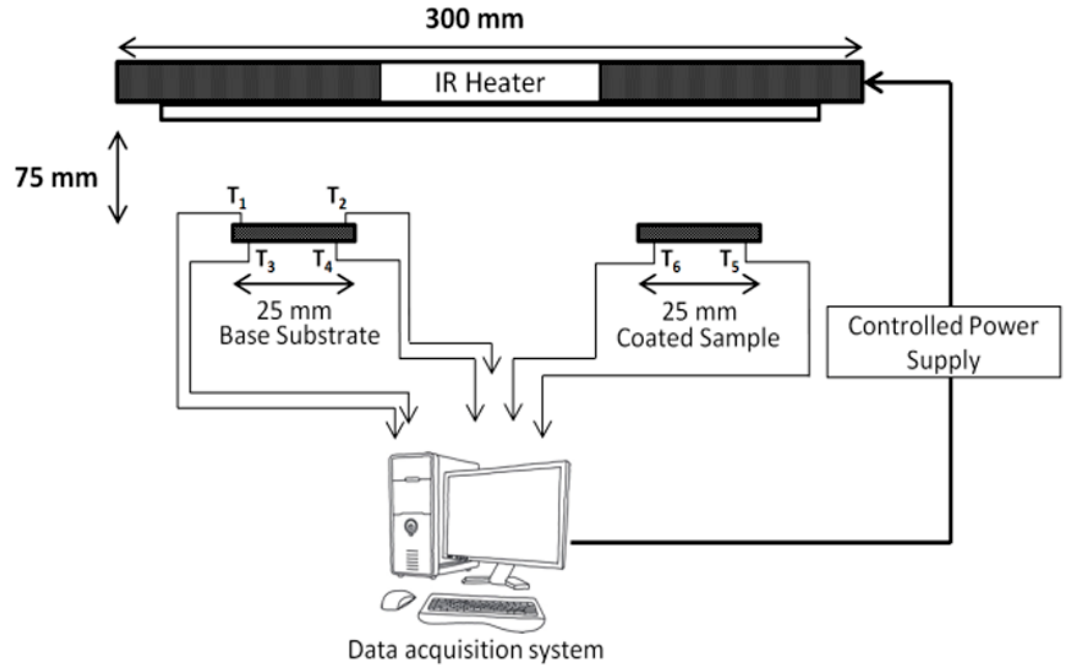
Figure 2. Schematic of infrared (IR) rapid heater.